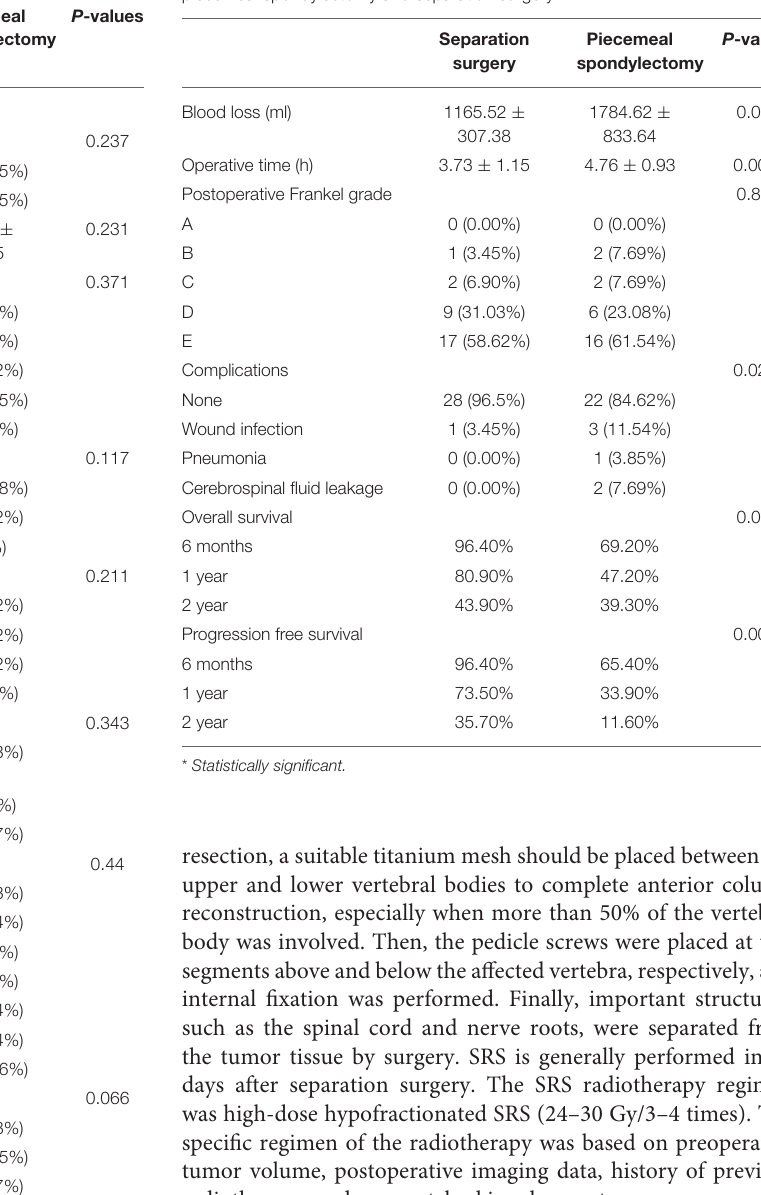
TABLE 2 | Comparisons of perioperative and postoperative data between piecemeal spondylectomy and separation surgery.